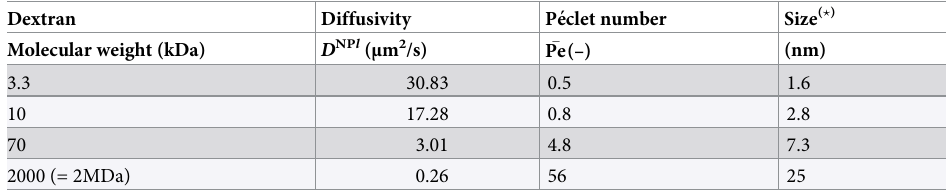
( ? ) Molecular size is expressed as the hydrodynamic radius determined by the Stokes-Einstein equation. Values are taken from Dreher et al.